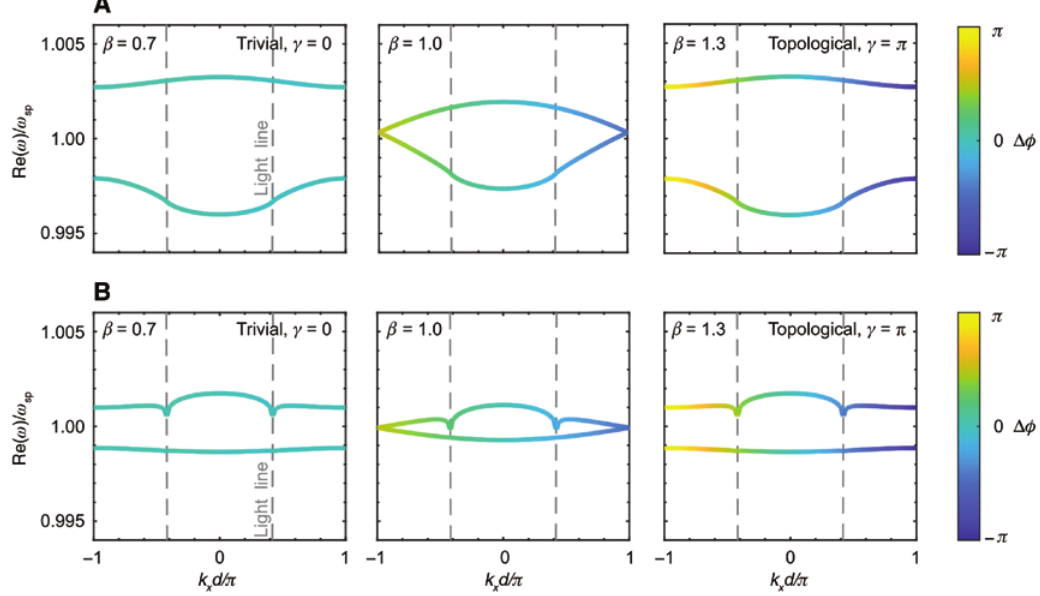
d = 0.42 π , which corresponds to sp